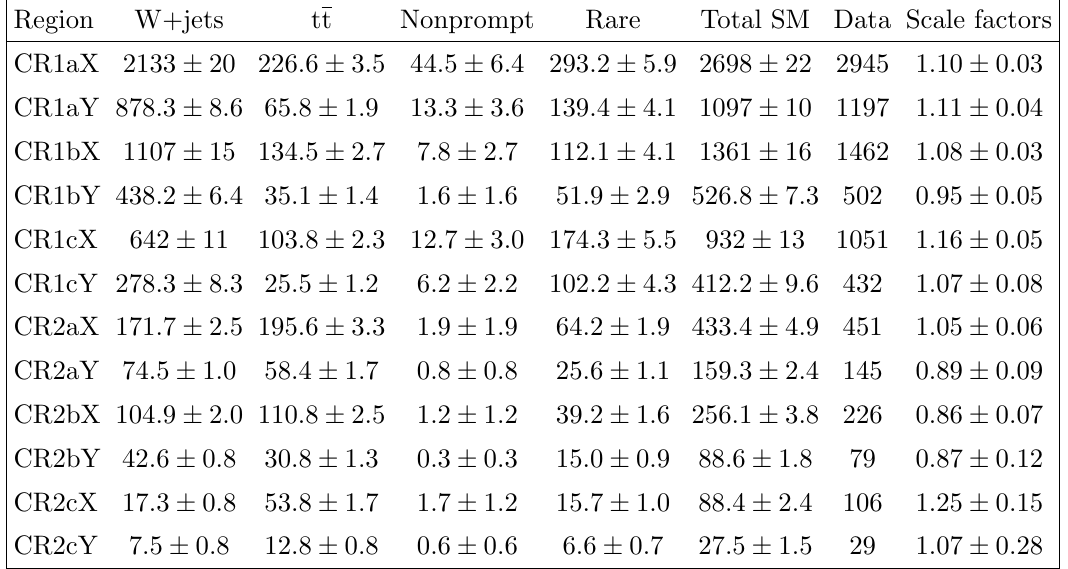
Table 2 . The CC search: observed yields and simulated background contributions to CRs nor- malized to an integrated luminosity of 35.9 fb (cid:0) 1 . The nonprompt contributions are estimated from data. The last column shows the scale factors used for the normalization of the W+jets and tt samples. Only statistical uncertainties are